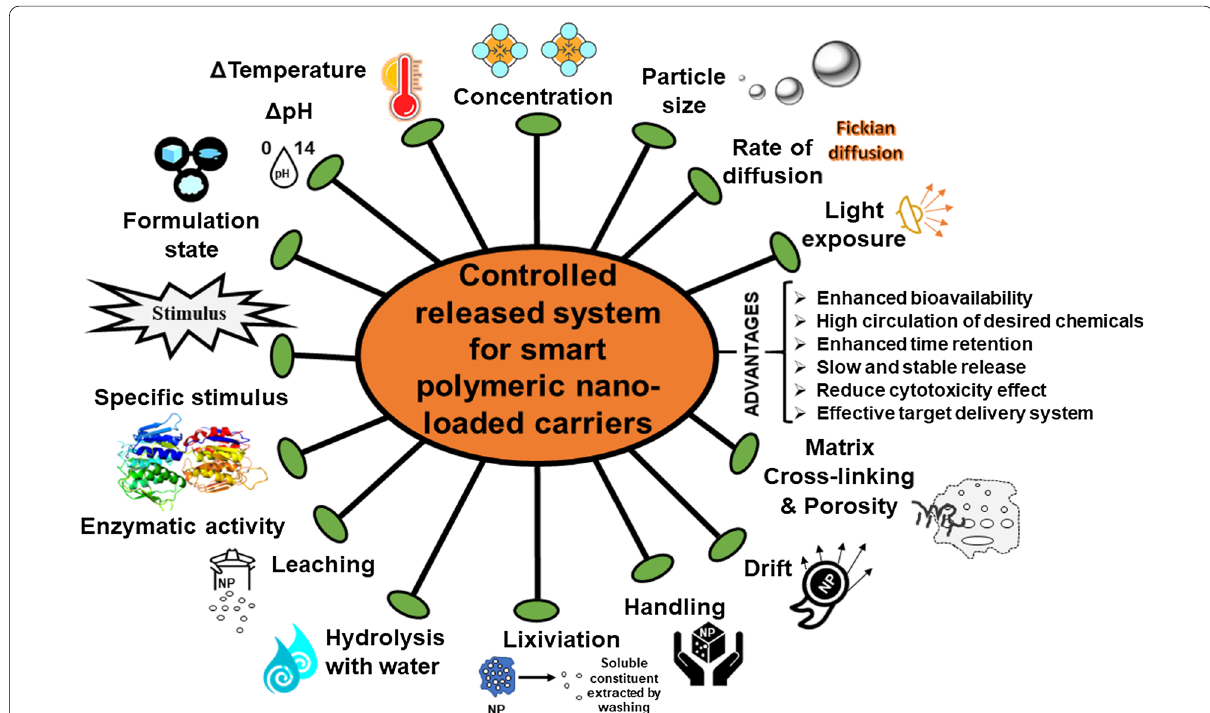
Fig. 2 Types of nanoparticle delivery